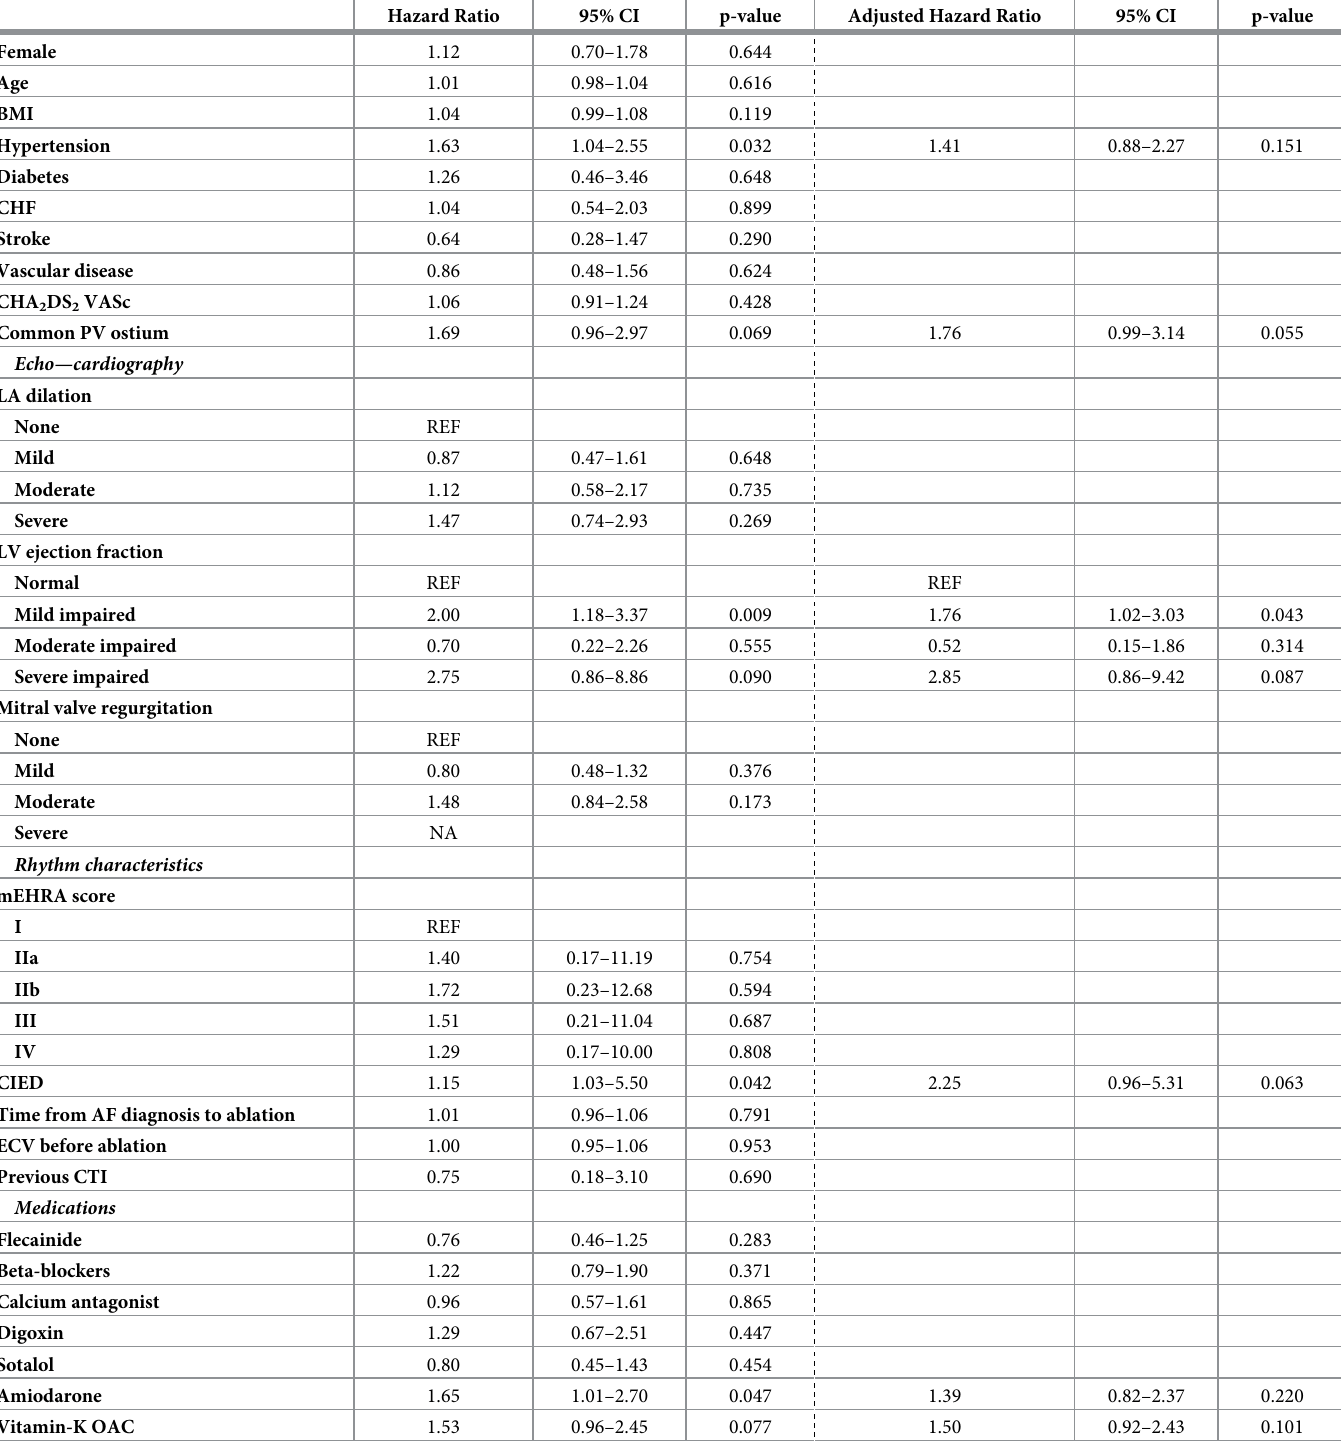
Table 2. Regression analysis for recurrence of any atrial